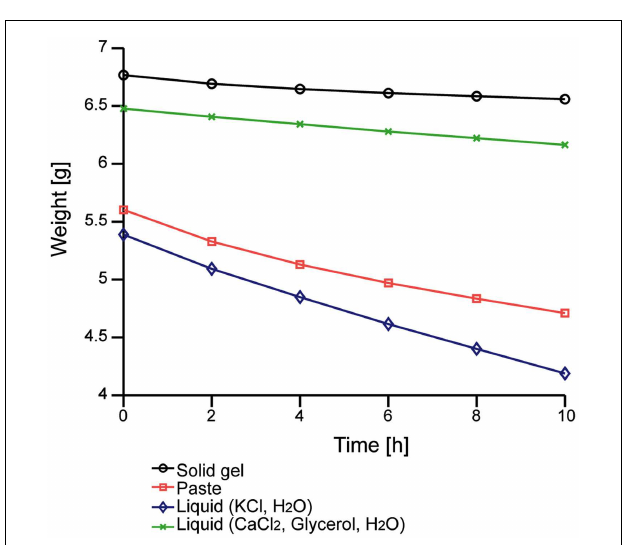
FIGURE 3 |Time-dependent changes in the weight of the solid-gel and other materials. Data of four materials were taken simultaneously.